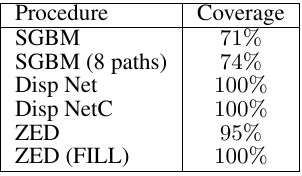
Table 2. Mean coverage of disparity maps. First line - Procedure, second line -